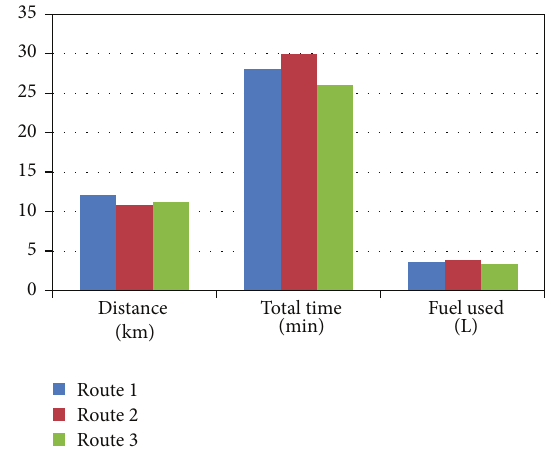
Figure 10: Bar graph for the distance, total travel times, and fuel used in heavy